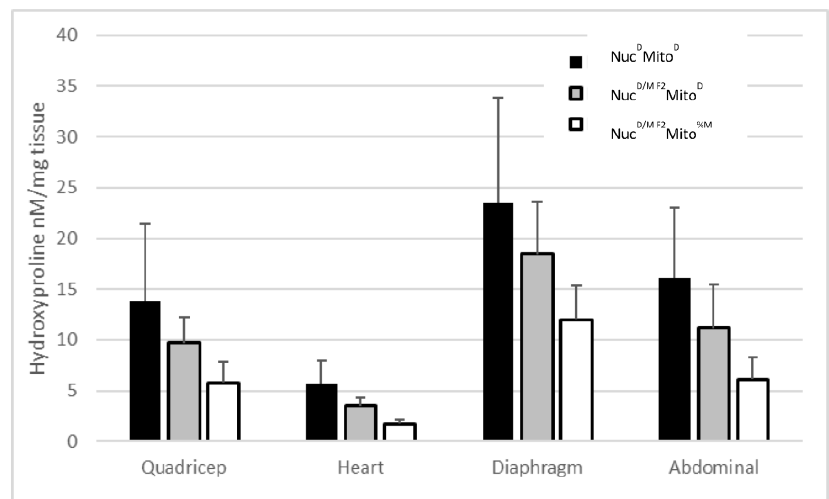
Figure 2. Both the MRL nuclear and mitochondrial genomes contribute to the muscular dystrophy phenotype reduction. These data are a reanalysis of the F2 mice from a previous work [4]. We used the hydroxyproline assay to measure fibrosis of the striated muscles. The Sgcg – / – Nuc D Mito D mice have the highest hydroxyproline levels for the tissues (black bars), the F2 mice that were 50% MRL and 50% D2 nuclear with D2 maternal inheritance had some benefit of fibrosis reduction (grey bars), and the F2 mice that had 50% MRL and 50% D2 nuclear with MRL maternal inheritance had the lowest fibrosis levels (white bars). This analysis was simply based upon maternal inheritance; these mitochondrial genomes are therefore undefined heteroplasmic Mito %M . N > 10, averages with standard deviations.